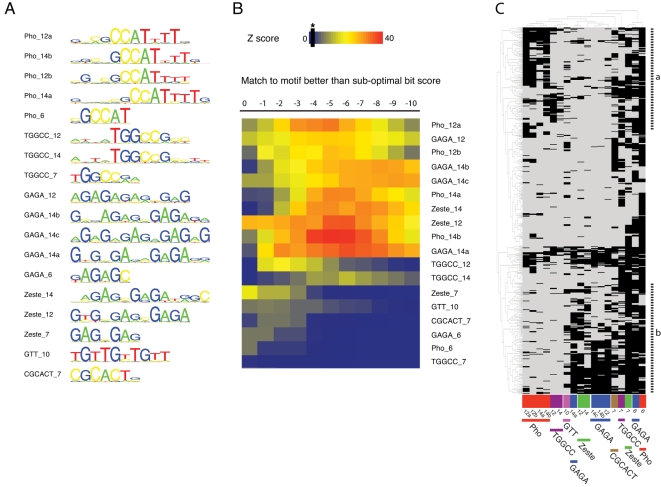
Sequence motifs identified in Pho-bound regions.(A) Selection of 18 motifs chosen for further analysis. The motifs can largely be grouped into clusters of similarity to the canonical Pho, GAGA and Zeste binding sites. The TGGCC motifs form a distinct class related to the canonical Pho motif. The GAGA- and Zeste-like motifs differ as Zeste-like motifs have a pronounced “GAG”, although this classification is arbitrary. Motifs are named according to class with a suffix indicating motif length. (B) Motif over-representation heat map. For each motif, a search for sequence matches with decreasing similarity (sub-optimal bit score) was conducted. The over-representation is measured as a Z-score, comparing the number of actual Pho peaks containing the motif to the number of occurrences in a random data set. This analysis confirms the statistical over-representation of all motifs, and suggests cutoff values for the sub-optimal bit score. (C) Bi-clustering of motif occurrence in 628 embryonic Pho peaks. Each column represents one of the 18 selected motifs, each line one of 628 embryonic Pho peaks. Rows and columns are ordered according to similarity. Motif presence better than the motif-specific sub-optimal bit score is denoted as a black mark. The motif type is indicated below the diagram. Peaks in region indicated by (a) have long Pho/TGGCC motifs but lack long GAGA/Zeste motifs while the peaks in region (b) show the opposite.